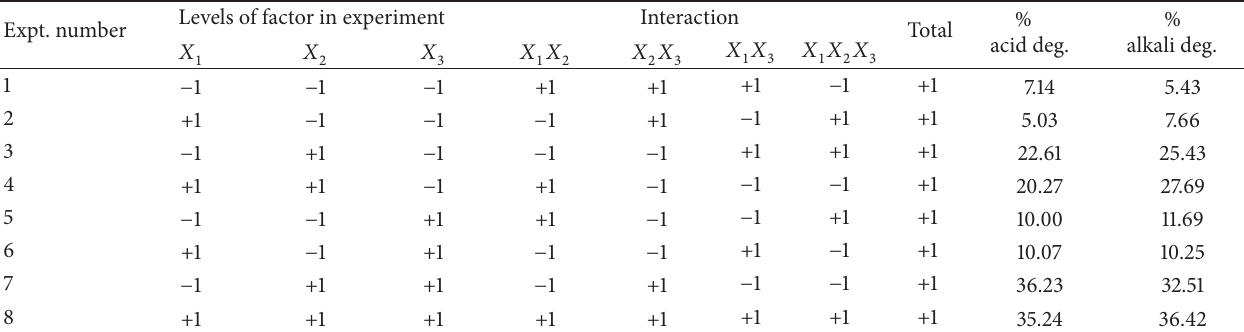
Table 1: Experimental matrix of 2 3 factorial design for acid and alkali degradation. Expt.